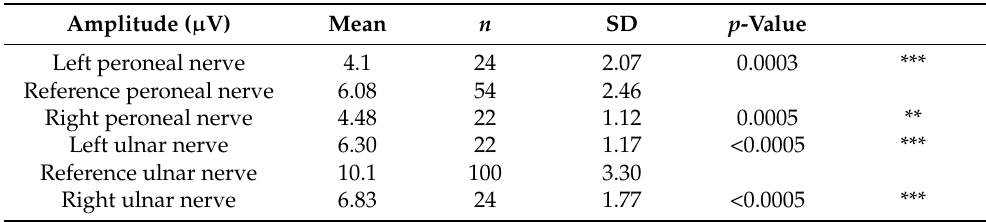
Table 6. Motor neurography amplitudes for left and right peroneal and ulnar nerve. ** and *** indicate statistically significant differences to reference material with p -values corresponding to Bonferroni corrected 0.01, and 0.001, respectively.